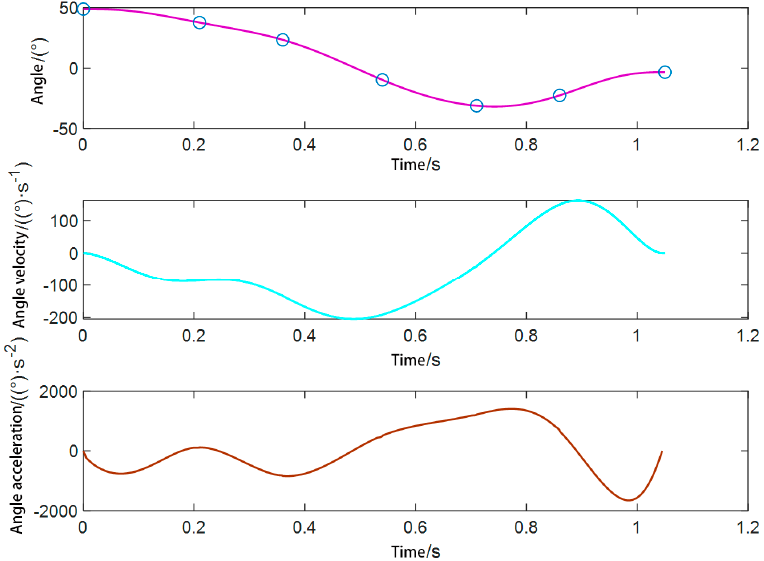
Figure 9. Plot of the angle, angle velocity, and angle acceleration of joint 1.